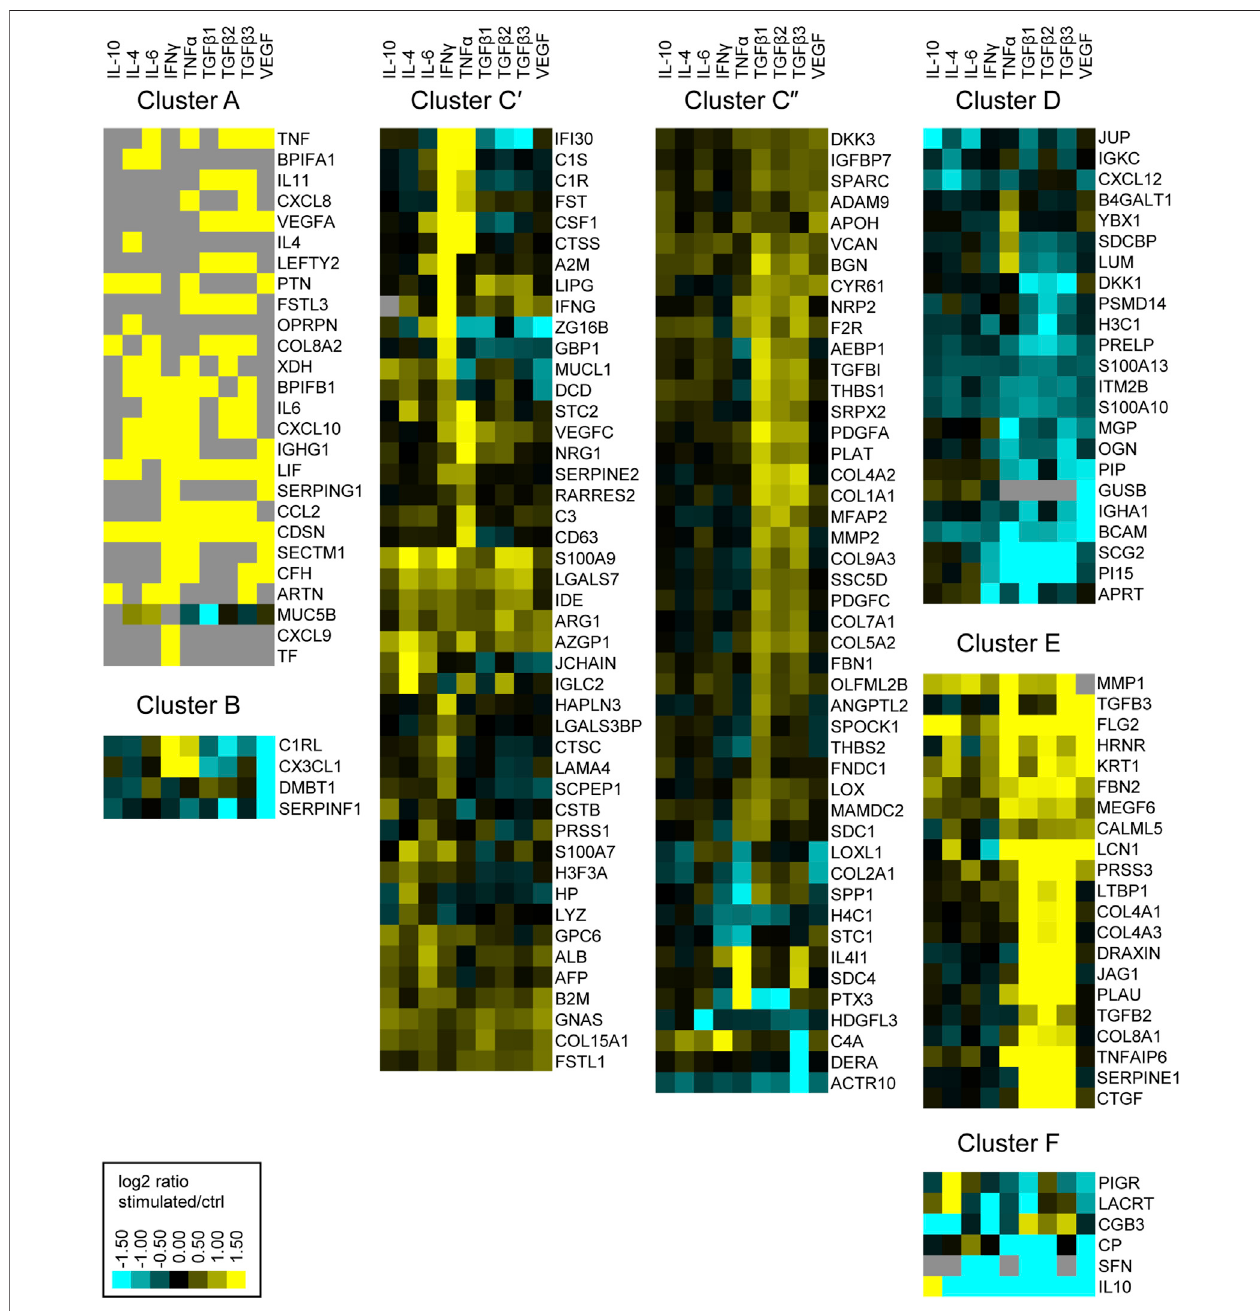
FIGURE2| HeatmapofhierarchicalclusteranalysisofproteinssecretedbyMIO-M1cellsaftertreatmentwithvariouscytokinesseparately.Identi fi edproteinswere fi ltered for extracellular proteins with signi fi cant changes in expression ( ± log2 (1.5) fold expression, corrected p -value ≤ 0.05). Down-regulated proteins are presented in cyan,while up-regulatedproteins aredepicted yellow fortherespectivetreatments.Gray squares representproteins thatwereneitheridenti fi edintheuntreated control, nor in the respective treatment. Clusters were de fi ned using the branches of a dendrogram and shown as close up with the corresponding gene symbols.